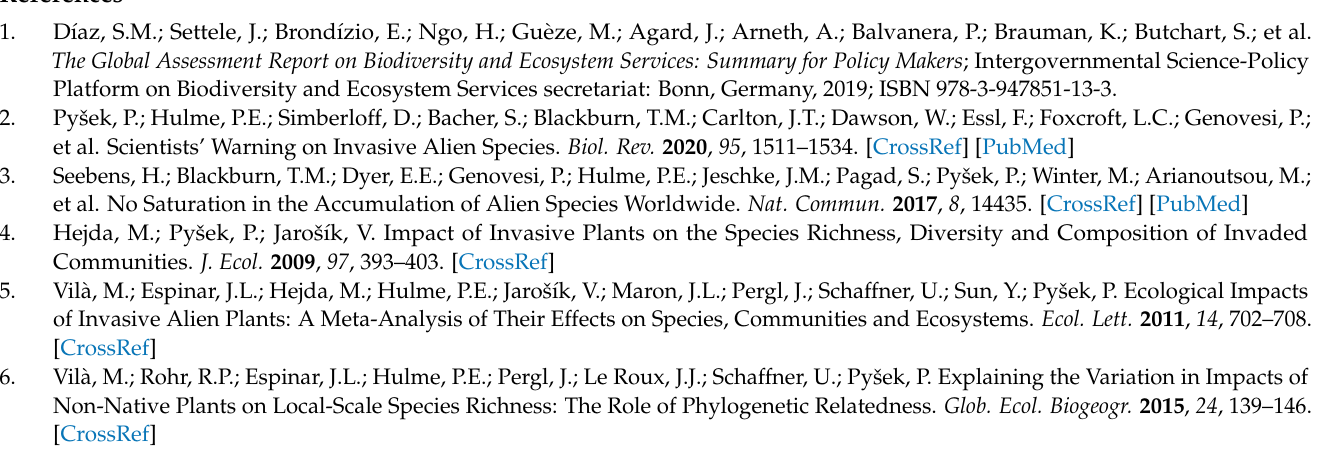
Table S3: Vegetation total mean cover values of sampled plots; Table S4: abbreviations for plant names used in Table S2 and Figure 4; Table S5: Climatic data for Giglio